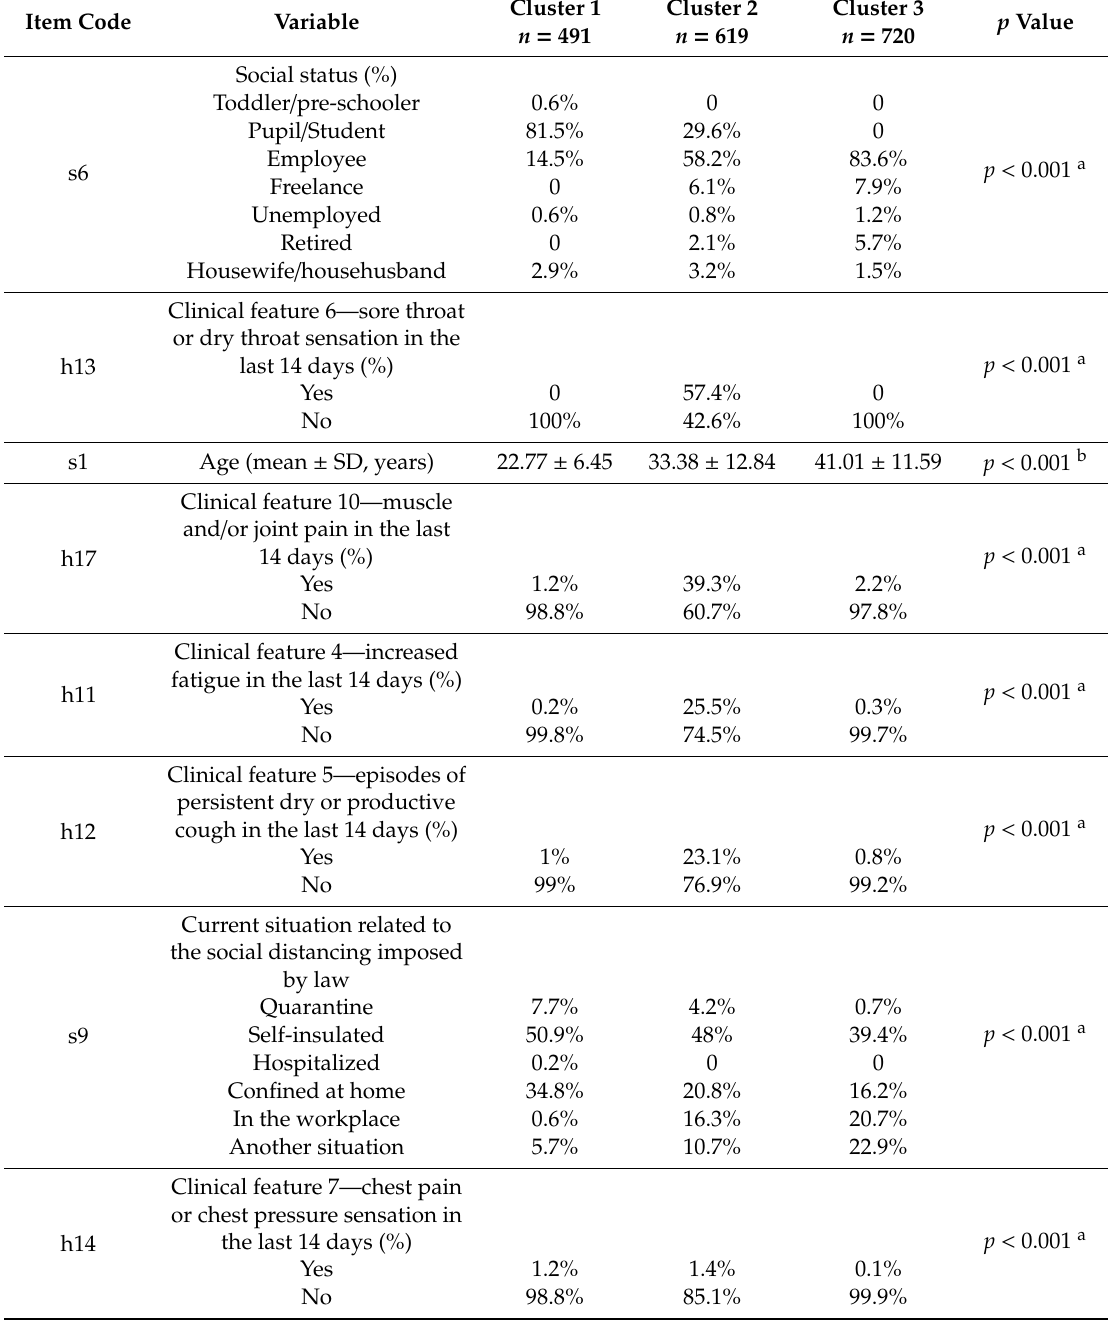
Table 7. Characteristics of the three clusters identified by two-step clustering with variable selection based on